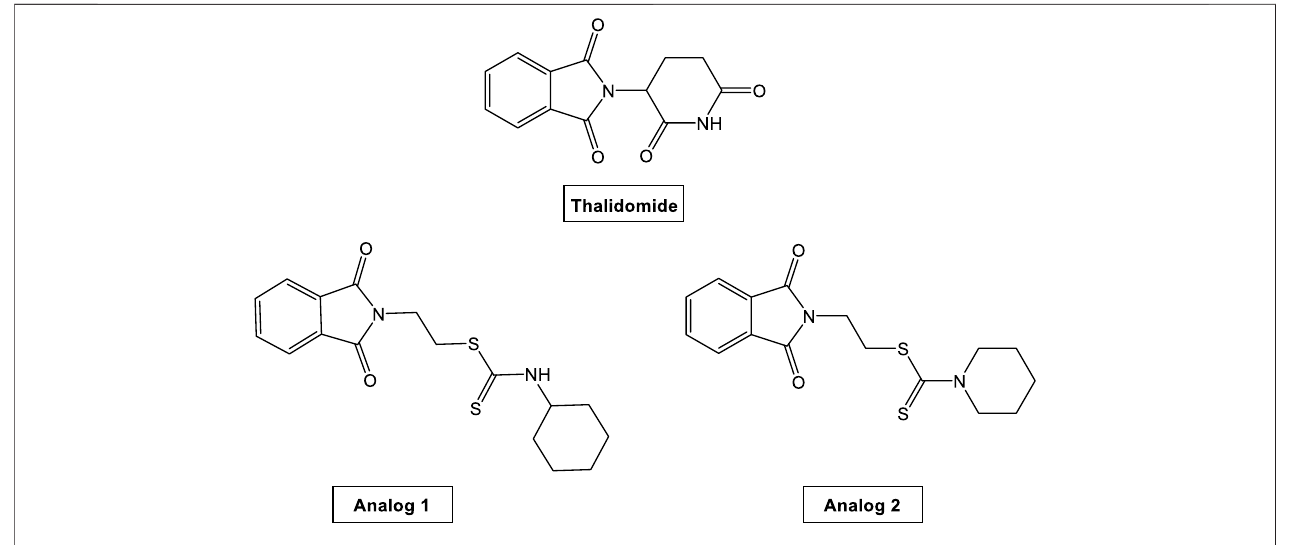
FIGURE 1 | Chemical structures of TH and its